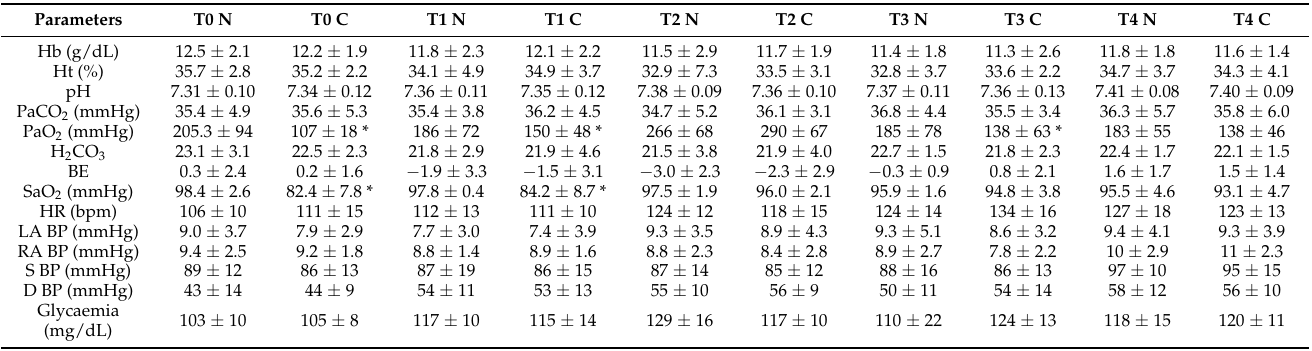
Table 2. Laboratory and monitoring parameters in cyanotic (C) and non-cyanotic congenital heart disease (N) children at different monitoring time-points: before the surgical procedure (T0); during the surgical procedure after sternotomy before CPB (T1); at the end of the cross-clamp CPB phase (T2); at the end of CPB (T3); at the end of the surgical procedure (T4); and, at 24 h after the surgical procedure (T5). * p <